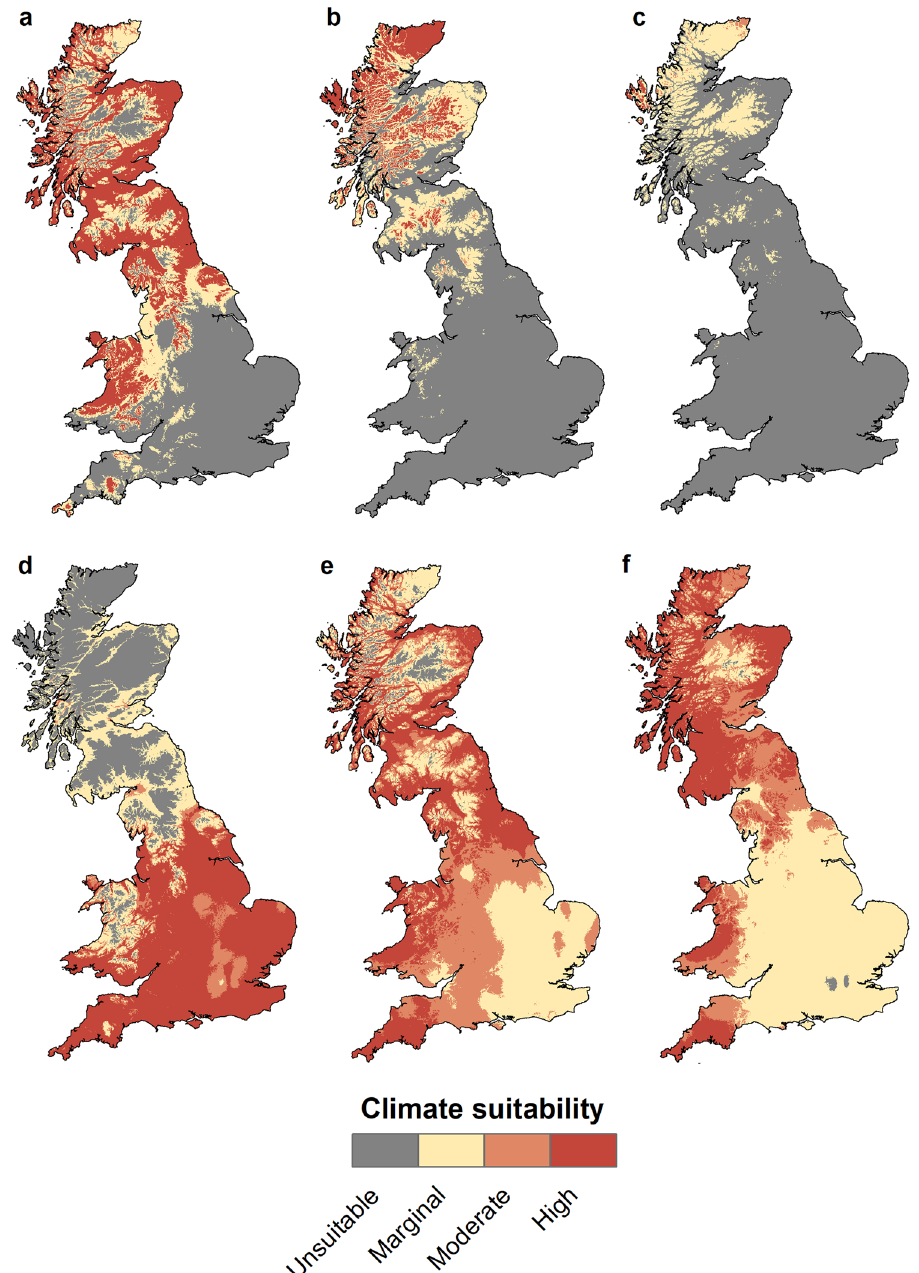
Fig. 2 Predicted climate suitability for HbS and HbF. Panels a - c represent HbS, panels d - f represent HbF. a , d Present climate. b , c , e , f Optimistic ( b , e ) and pessimistic ( c , f ) future climate warming scenarios for 2070 (see text for details). The fi gure was created using ArcMap (v.10.8) and the Esri world countries dataset